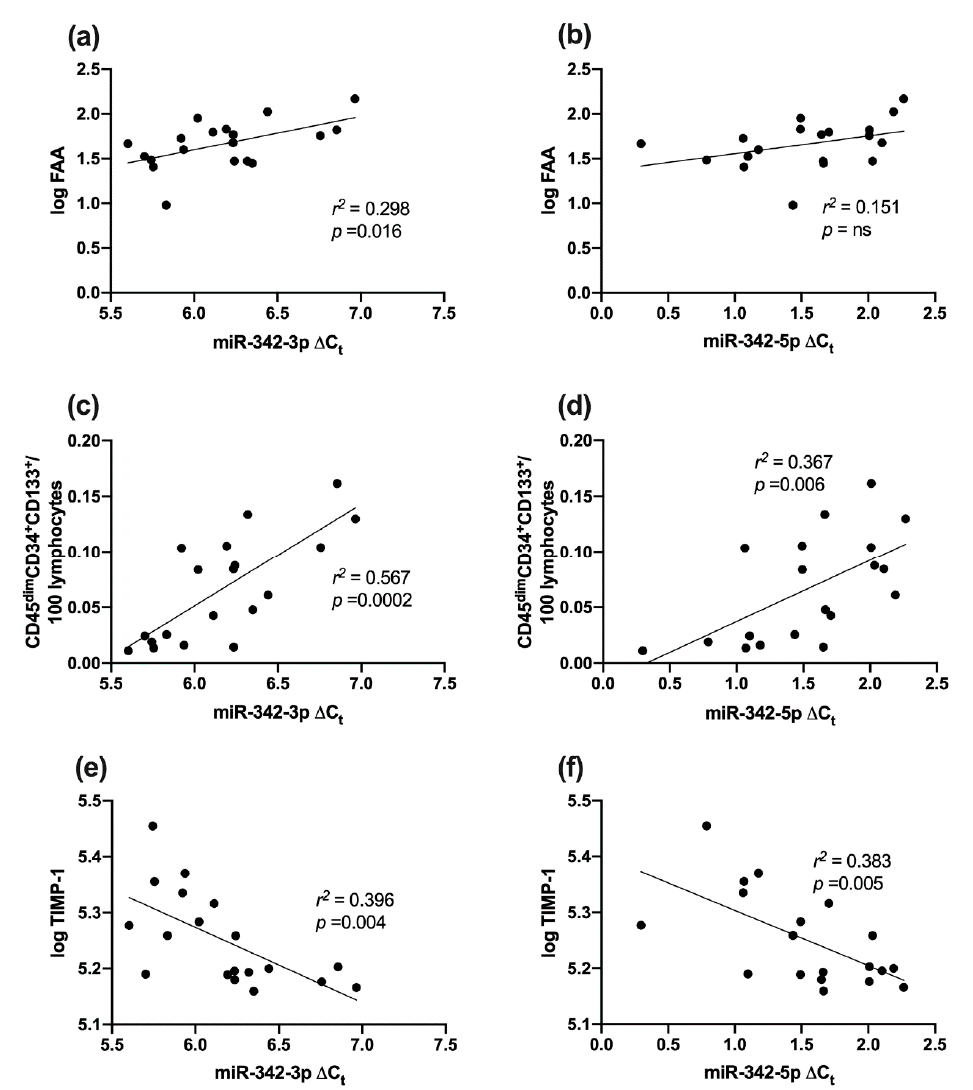
Figure 3. Correlation between miR-342-3p / -5p expression in PBMCs and vascular health in type 1 diabetes and healthy controls combined. ( a ) miR-342-3p and log FAA; ( b ) miR-342-5p and log FAA; ( c )miR-342-3pandCD45 dim CD34 + CD133 + ; ( d )miR-342-5pandCD45 dim CD34 + CD133 + ; ( e )miR-342-3p and log TIMP1 ( f ) miR-342-5p and log TIMP1. FAA—fibronectin adhesion assay; ns—nonsignificant; TIMP-1—tissue inhibitor of metalloproteinases